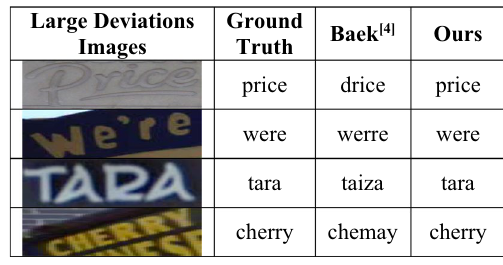
Fig. 13 Some samples with large